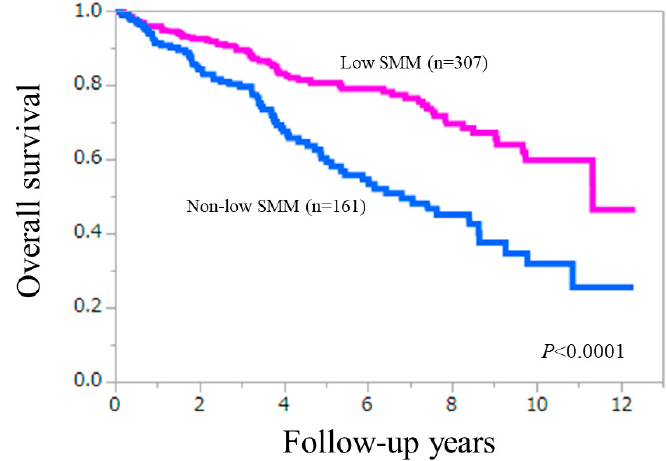
Figure 1. Kaplan-Meier curves in patients with low SMM ( n = 161) and without low SMM ( n = 307). The 3-, 5-, 7- and 10-year cumulative overall survival rates were: 79.5%, 60.3%, 49.5% and 31.8% in the low SMM group, and 89.4%, 80.6%, 76.5% and 59.7% in the non-low SMM group ( P < 0.0001).